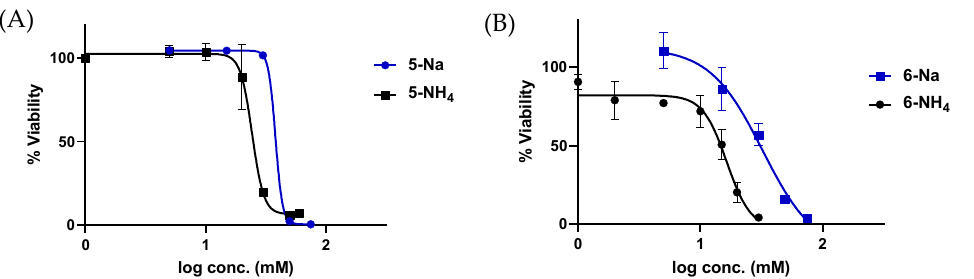
Figure 5. Plot of the % viability in HepG2 cells as a function of log concentrations. ( A ) Dose response activity of 5-Na and 5-NH 4 providing an LD 50 of 38 and 16 mM. ( B ) Dose response activity of 6-Na and 6-NH 4 providing an LD 50 of 32 and 24 mM. A non-linear regression curve was fitted to points to generate LD 50 values. Plates were run in duplicate with n = 7 sample size. Error bars represent % SD.